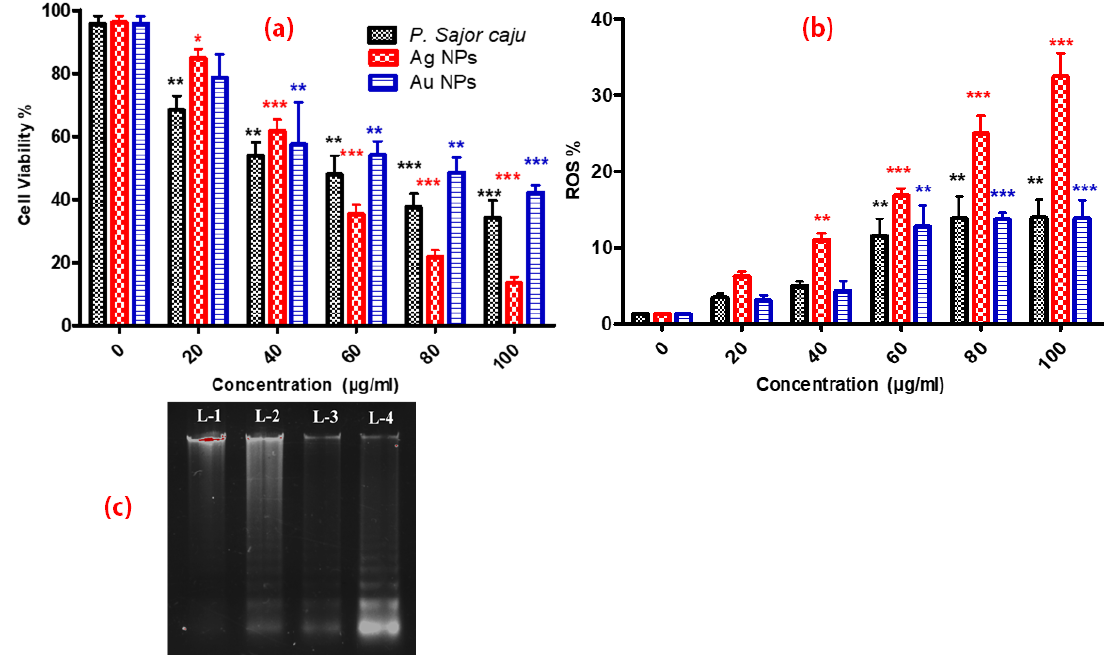
Figure 8. ( a ) Cell viability of HCT-116 cell line at various concentrations (20–100 µ g / mL) of PS extract, Ag NPs and Au NPs. ( b ) Intracellular ROS production against HCT-116 cell line at various concentrations (20–100 µ g / mL) of PS extract, Ag NPs and Au NPs. ( c ) DNA fragmentation assay using agarose gel electrophoresis. Lane 1- Control, Lane 2- aqueous PS extract, Lane 3- Au NPs, Lane 4- Ag NPs treated HCT-116 cell line. All data were analysed by one-way ANOVA using post hoc Dunnett’s test. p < 0.05 was considered to be statistically significant between exposed and control groups. The symbols *, **, *** show statistical significance using one-way ANOVA ( p < 0.05, p < 0.01, p <